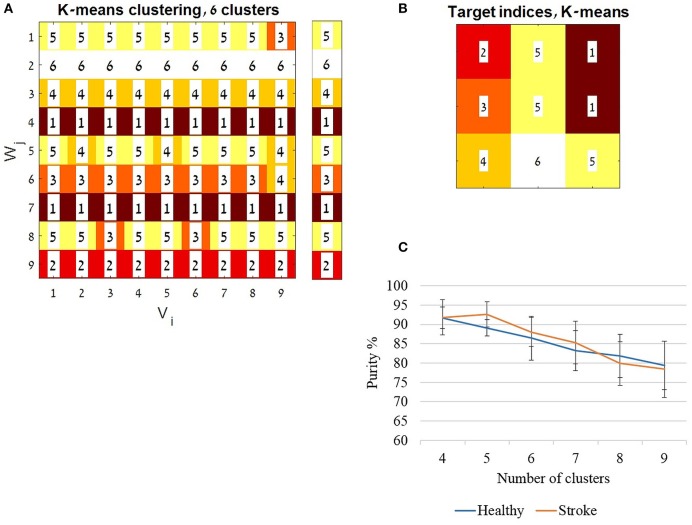
The K-means algorithm. The K-means algorithm was applied for validating the application of a representative set synergies, using the full activation coefficients (H matrices). For each group the cross validation procedure yielded 81 full coefficient matrices (H). A constant set of features (see also method section) was extracted from each matrix. Each of the H matrices features was calculated as a data point (a single row), which composed of 44 features (11 features × 4 synergies). The K-means algorithm was iterated 10 times, changing the number of clusters/ centroids (K) from four to nine. The clustering indices were ordered to be aligned with the cross validation matrix (Figure 3) as illustrated in (A). Each row was assigned to a cluster index value given by the MATLAB algorithm, according to the most common index in a row. The assigned indices are shown in the legend bar (A). The accuracy of classification was computed using the purity index (see also method section) for each running of the algorithm with each K's. In (A) for example the purity was calculated as follow: ((8 + 9 + 9 + 9 + 6 + 8 + 9 + 7 + 9)/81)*100, which resulted in 91.358% accuracy. (B) Illustrates the location of the indices ordered according to the target directions as in Figure 1B. (C) The average accuracy from the 10 iterations for each K was computed and plotted, for each group separately.